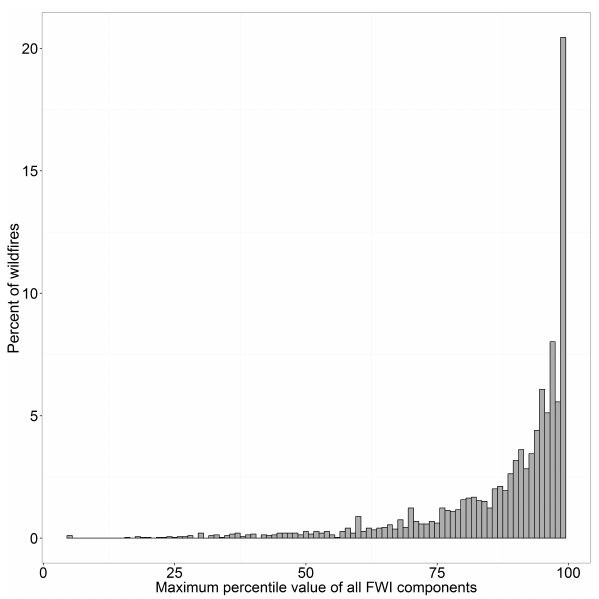
Figure 5. Frequency distribution of the maximum percentile value calculated for all of the FWI components during each event, for all IRS wildfires recorded in 2010–2012. For each IRS wildfire event, the maximum percentile value of each of the six FWI components was calculated, and the largest of these was then used to construct this frequency